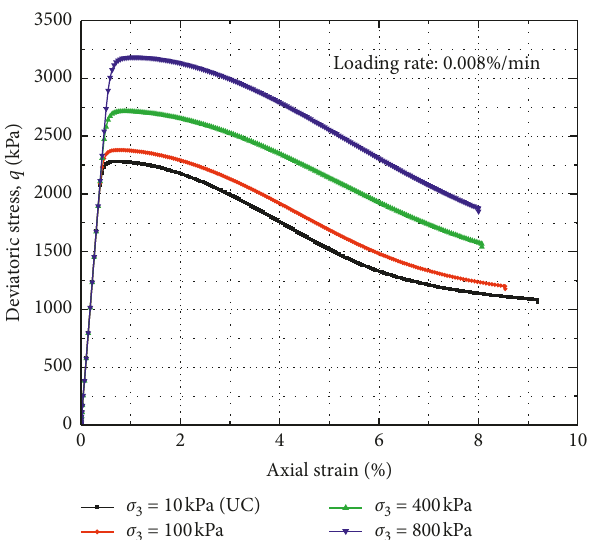
Figure 5: Deviatoric stress versus axial strain (%) for various confining stress for a single strain rate. Displacement control analysis is done.